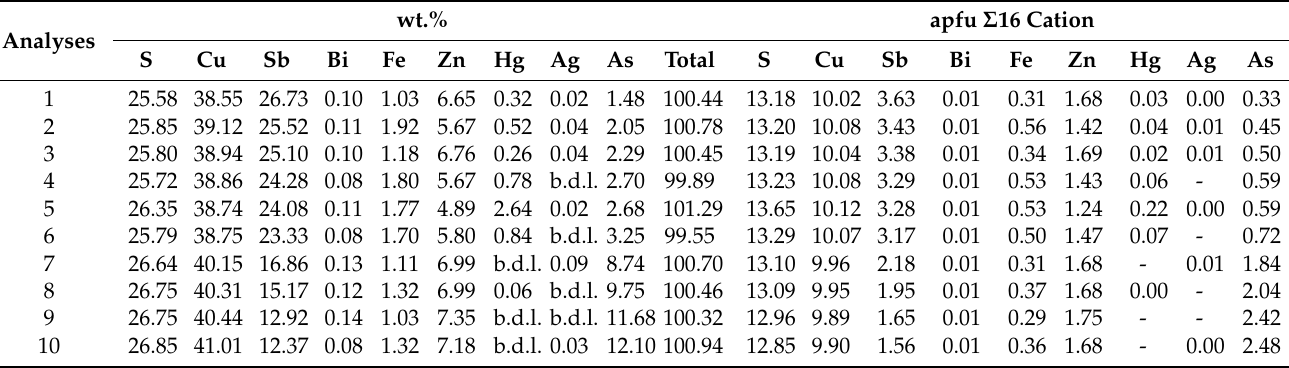
Table 5. Representative EPMA data for TGM: tetrahedrite-(Zn) [1–7] and tennantite-(Zn) [8–10] from Kizhnica quarry: polymetallic veinlets [1–6] and breccia [7–10], b.d.l. = below detection limit. wt.% apfu Σ 16 Analyses